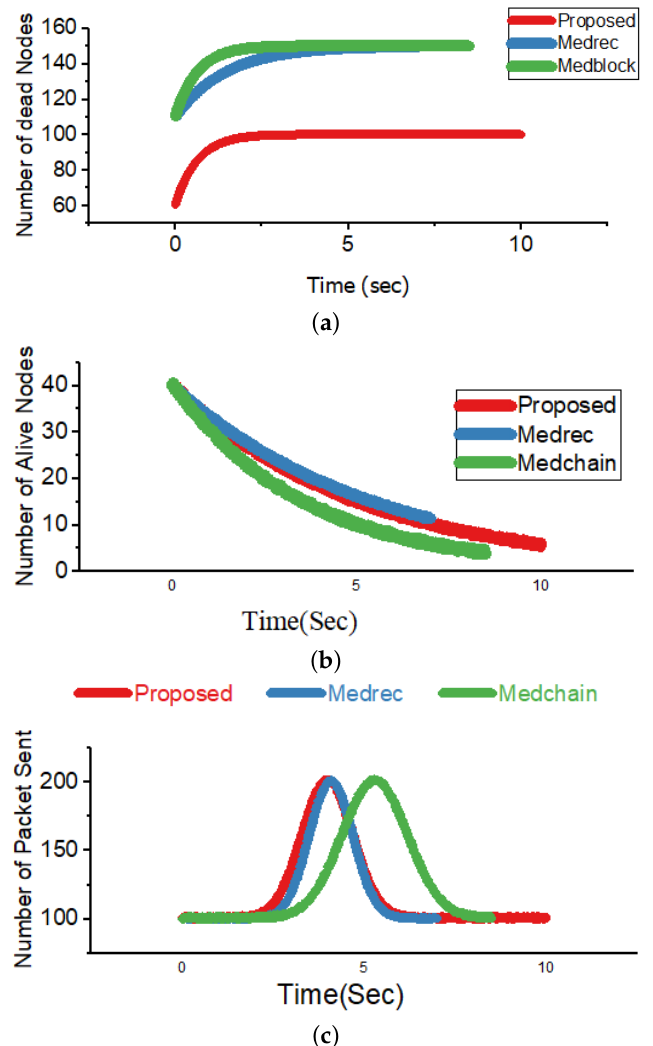
Figure 16. Comparison of our proposed method with the benchmark models [49–51] in terms of: ( a ) the number of dead nodes, ( b ) number of live nodes, and ( c ) number of packets